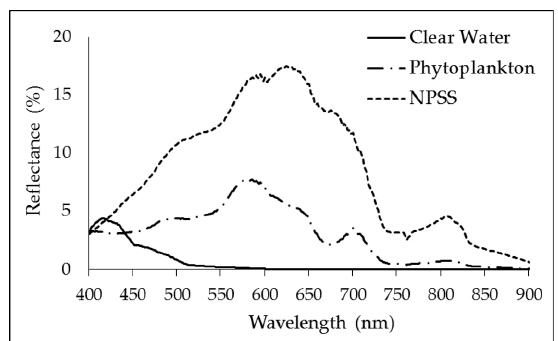
Figure 10. The standard reflectance spectra of three endmembers simulated using the Bio-Optical model . NPSS: non-phytoplankton suspended sediments.